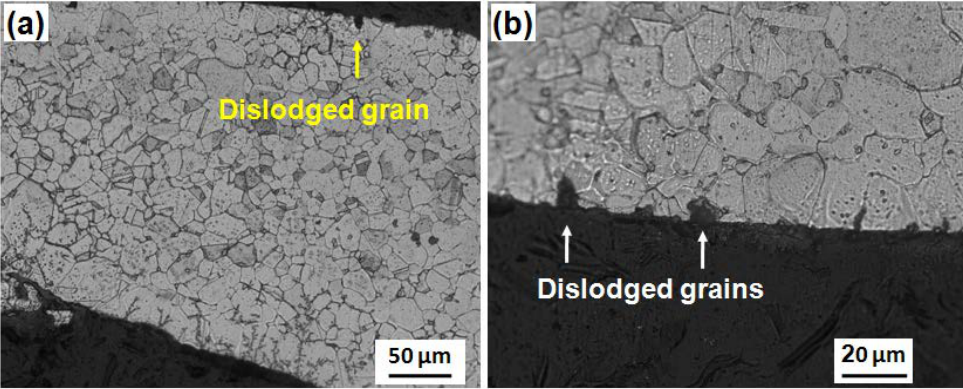
Figure 2: Optical micrograph of failed wire rope shows (a) austenite grain structure with few dislodged grains from the grain boundaries at the surface near fracture and (b) high magnification of Figure a.